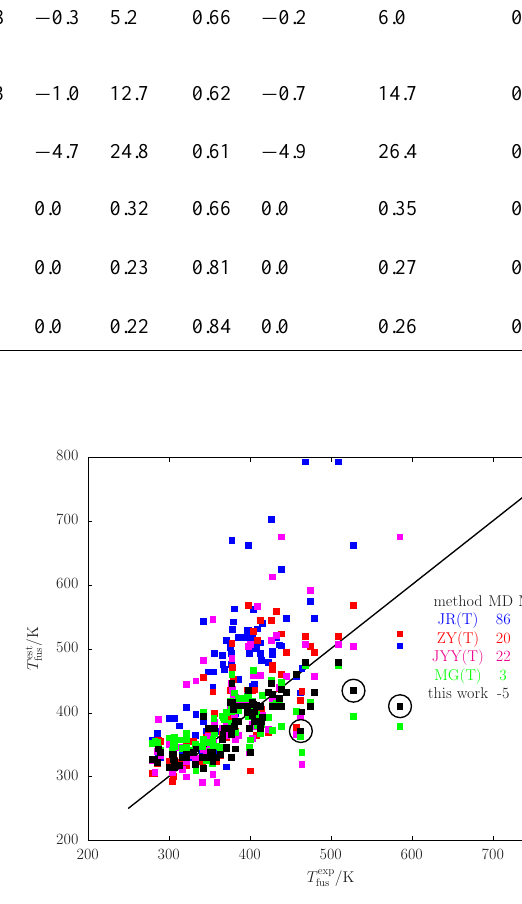
Fig. 4. Estimated vs. experimental T fus for various literature meth- ods, and the method developed in this work. The MD and MAD of the methods are also given. The 1:1 diagonal is indicated (black line). The three most important outliers of the new method are indi- cated by a circle (from small to high experimental T fus : 3-hydroxy- 2-(hydroxymethyl)-2-methylpropanoic acid, galactaric acid, trans - 1,4-cyclohexane dicarboxylic acid).